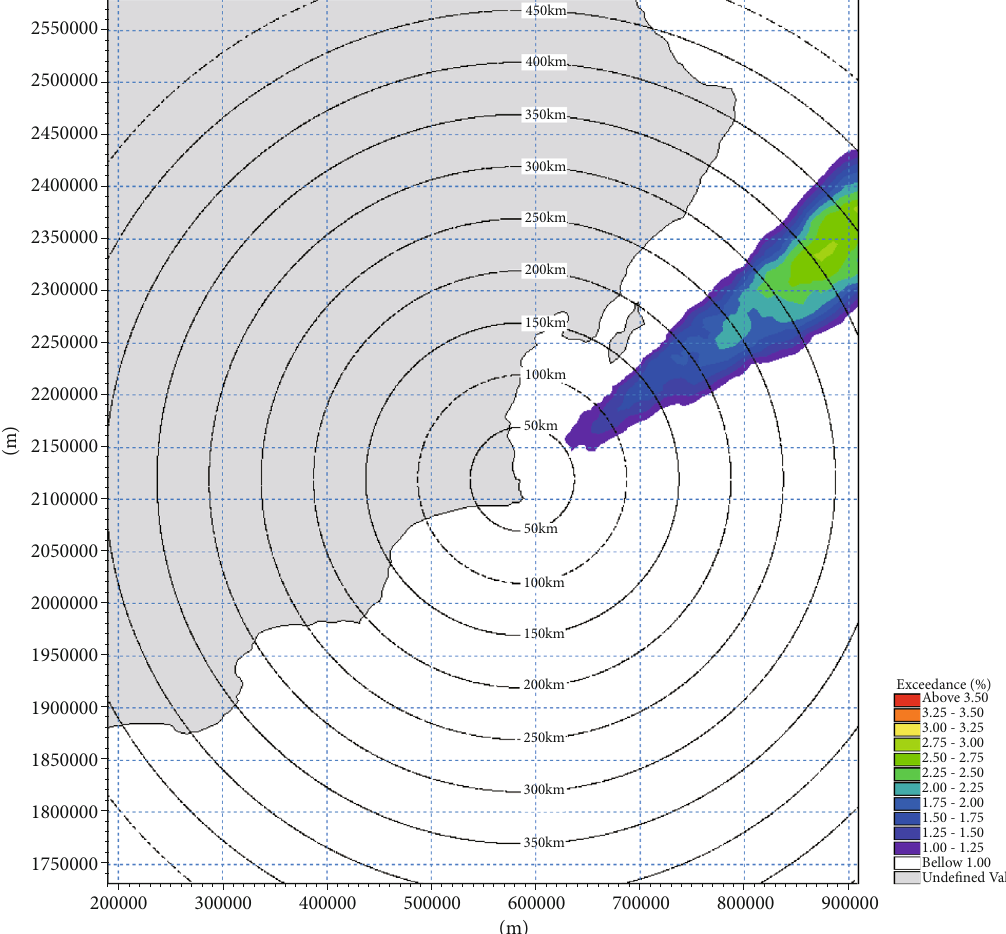
Figure 16: Exceedance probability of water surface oil thickness > 10 μ m for scenario 1 (sub-surface blowout: 16,000m3 spill at SPM1) — full model extent.